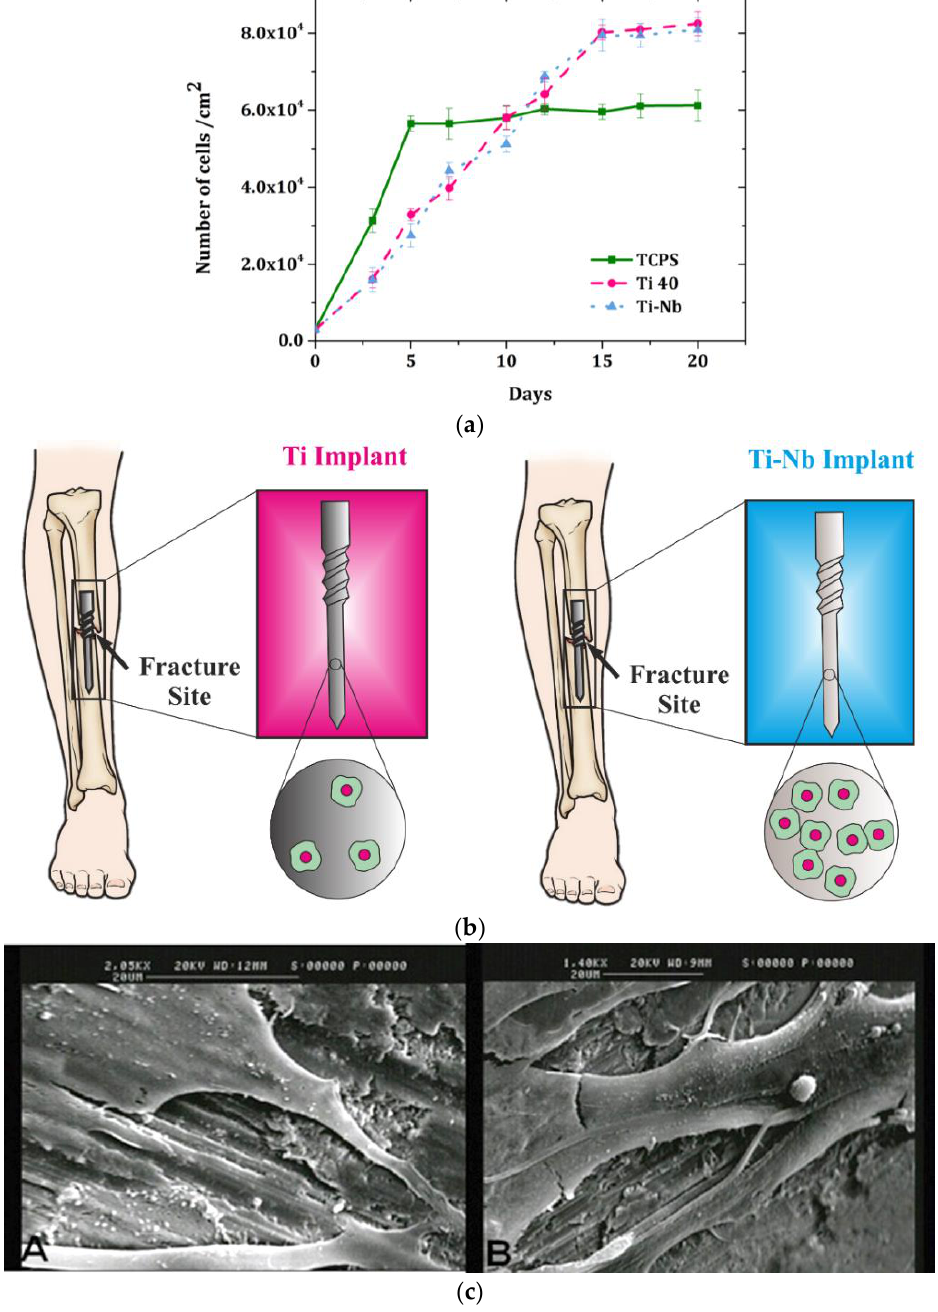
Figure 2. ( a ) Cell viability of fibroblasts under three culture conditions: culture on plastic control sample, Grade 2 Titanium alloy (Ti40), and titanium – niobium alloy (Ti-Nb), ( b ) Ti-Nb implant exhibits proper cell proliferation compared to the Ti implant, ( c ) SEM images of (A) cells grown on Ti40, G = 2050×; (B) cells grown on Ti-Nb, G = 1400×; image indicates the cell adhesion to the surface.